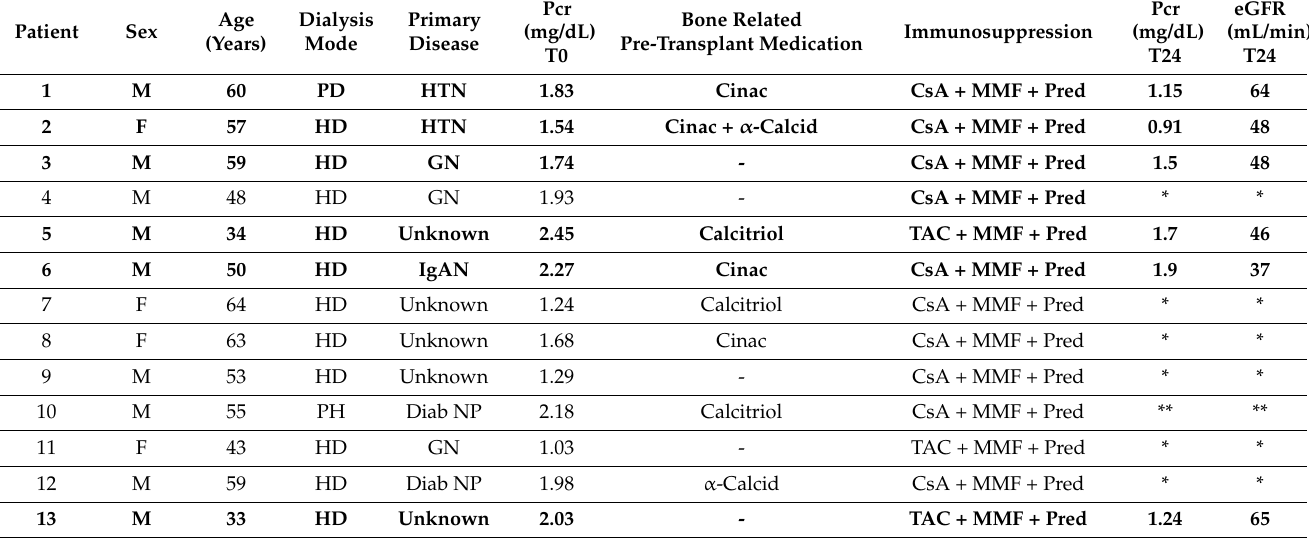
Table 1. Patient